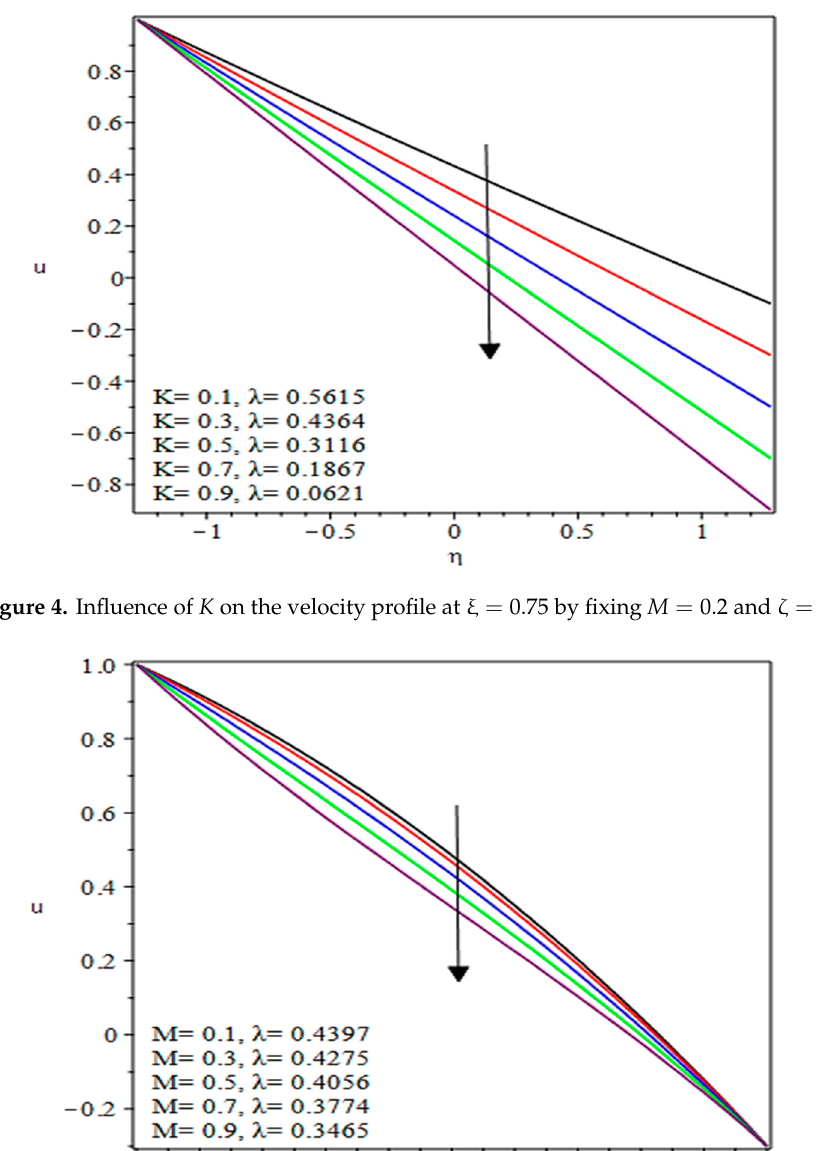
Figure 5. MHD parameter M influence on the velocity profile at ξ = 0 by fixing K = 0.1 and ζ = 2 .